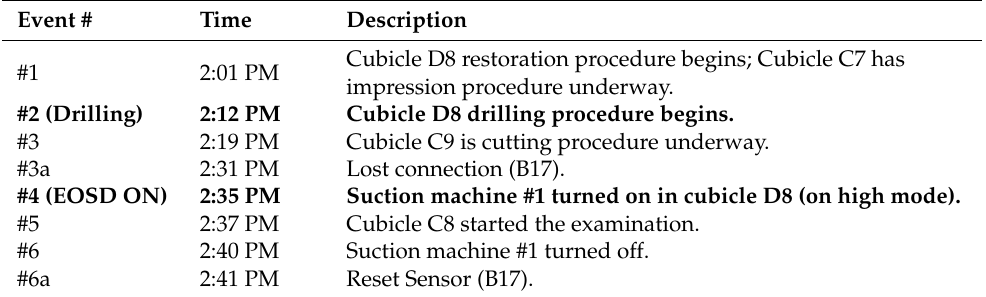
Table 2. Procedures in Cubicle D8.